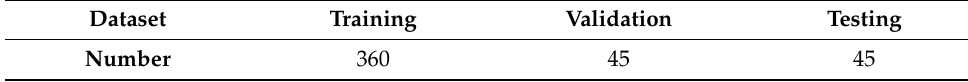
Table 3. Details of the forest fire and smoke